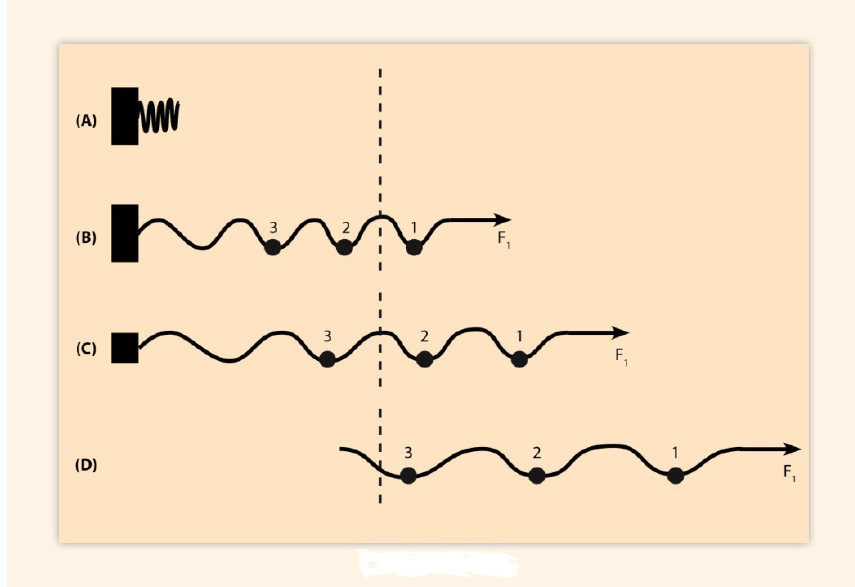
Figure 2. Elastic spring expansion (schematic). (Adapted from S. Papageorgiou J. Dev. Biol. 2021, 9(2) 17). ( A ) The compacted spring is at rest. ( B ) A small force F1 is applied to the right end of the spring. The spring fastening is complete (black orthogonal at the left end). The spring expands slightly and a small ball crosses the dashed line to the activation region. ( C ) The spring fastening is reduced (small black square at the left end). Two balls pass to the activation region. ( D ) The fastening is completely removed and, under the same force F1, all three balls are shifted into the activation region.